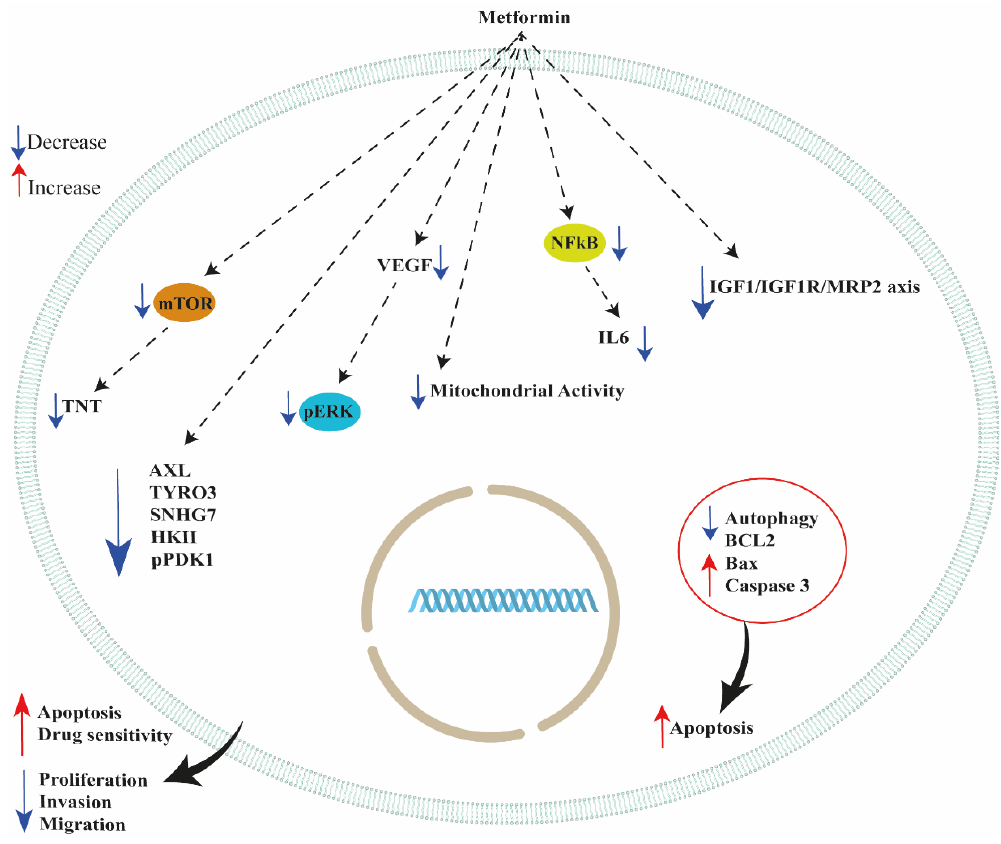
Figure 2. Schematic representation of metformin’s effects on ovarian cancer cells. Tunneling nanotube (TNT); Insulin-like growth factor 1 (IGF-1); IGF-1 receptor (IGF1R); Small nucleolar RNA hostgene 7 (SNHG7); Multidrug resistance-associated protein 2 (MRP2); Extracellular signal-regulated kinase 1/2 (ERK1/2); phospho-AKT (pAKT); nuclear factor kappa-light-chain-enhancer of activated B cells (NF- κB); Vascular endothelial growth factor (VEGF); Hexokinase II (HKII); phosphor- pyruvate dehydrogenase kinase-1 (pPDK1); B-cell lymphoma 2 (Bcl-2); Bcl-2-associated X (Bax); mechanistic target of rapamycin (mTOR)